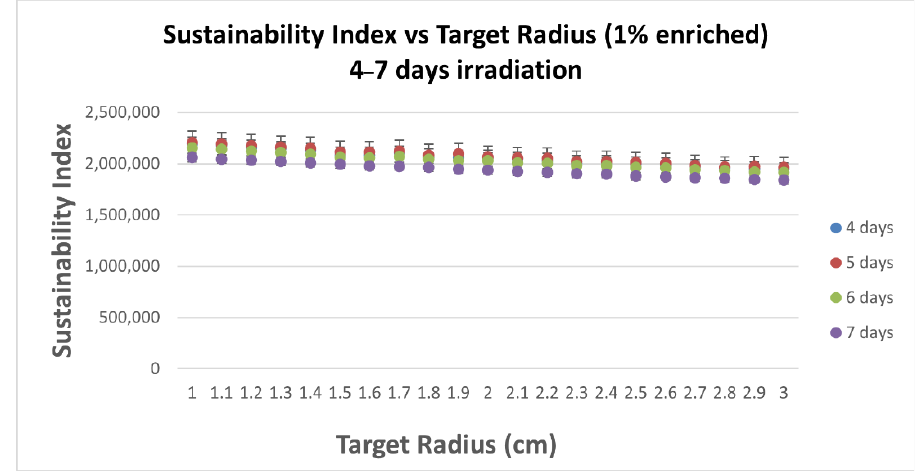
Figure 7. Sustainability index versus target radius for a fixed target height of 10 cm.